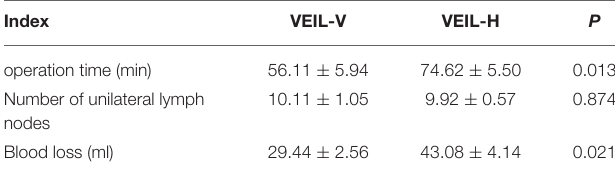
TABLE 2 | Comparison of indexes during